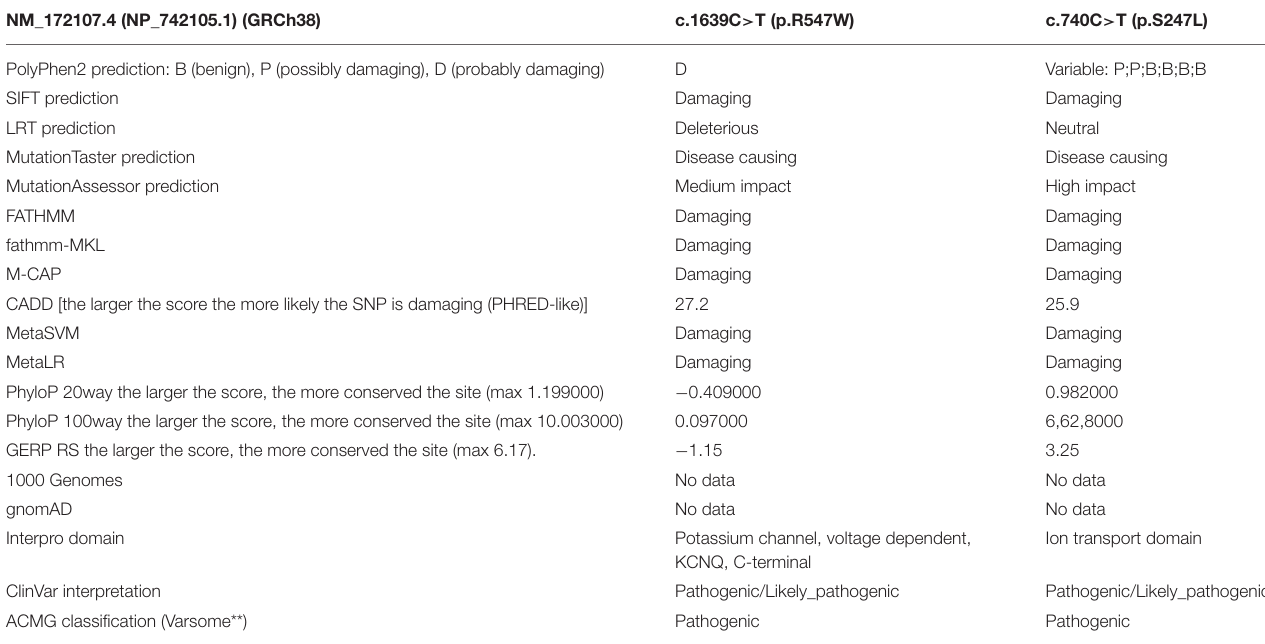
TABLE 2 | In silico prediction of the KCNQ2 missense mutations *